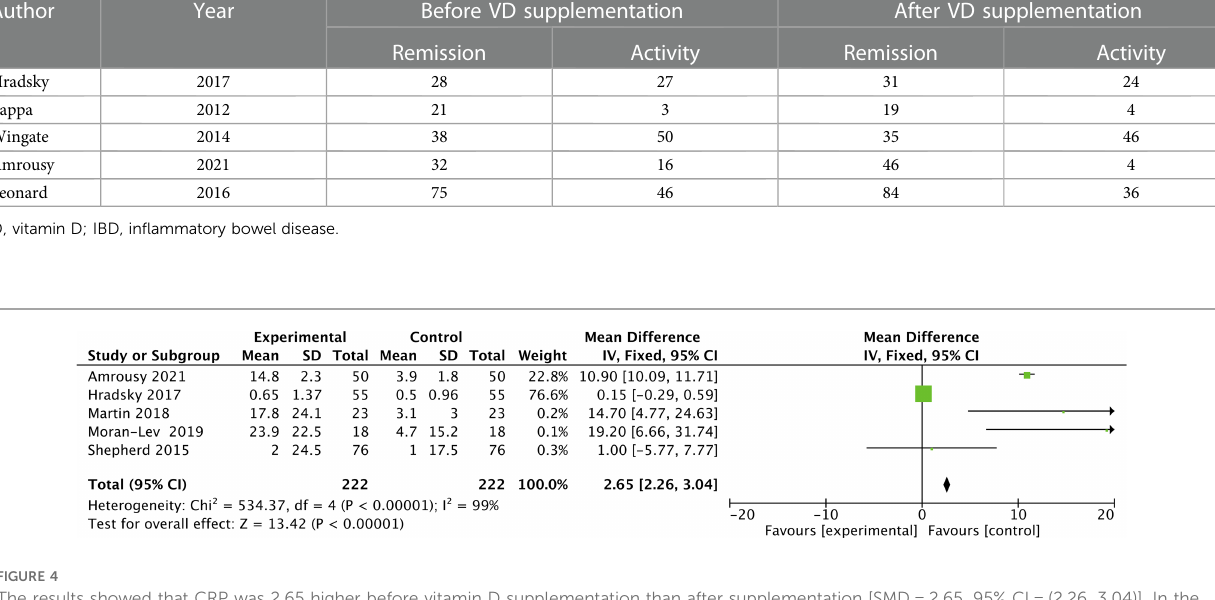
TABLE 4 Changes in remission IBD patients before and after VD supplementation. Author